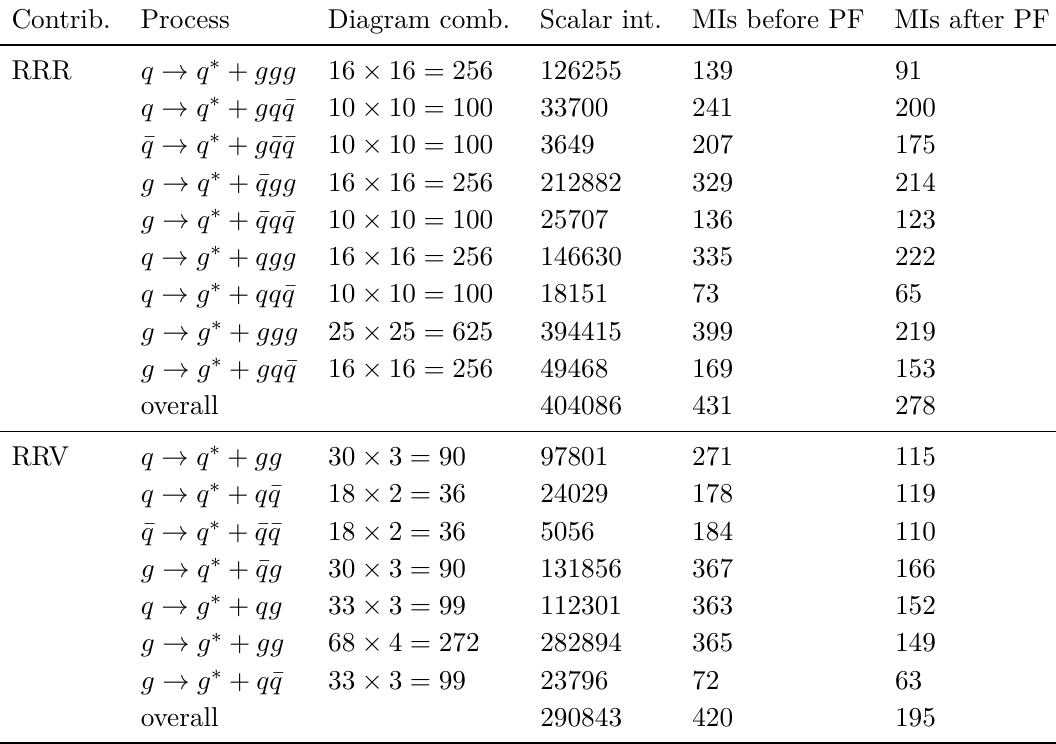
Table 1 . We show, for individual partonic processes, the number of combinations of relevant diagrams, the number of scalar integrals before IBP reduction, as well as the number of master integrals before and after eliminating partial fraction (PF) relations between master